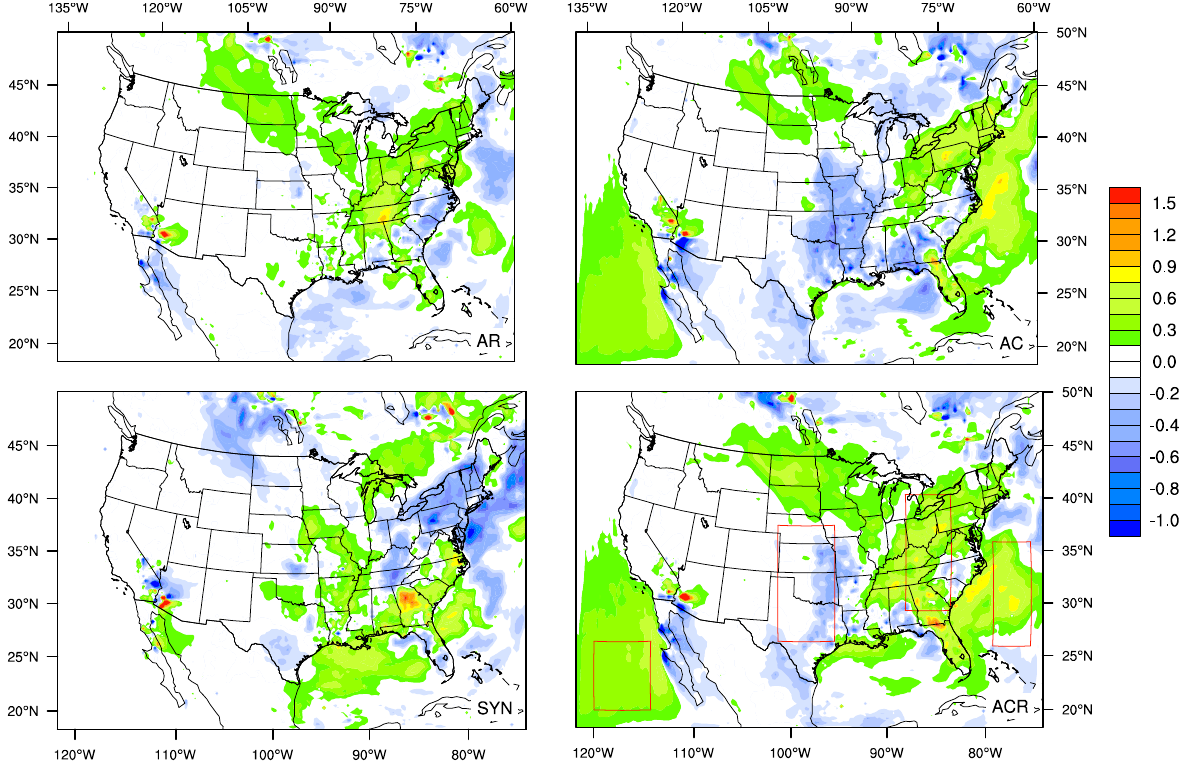
Figure 9. Same as Figure 8 except for surface PM2.5 concentration ( μ g·m − 3